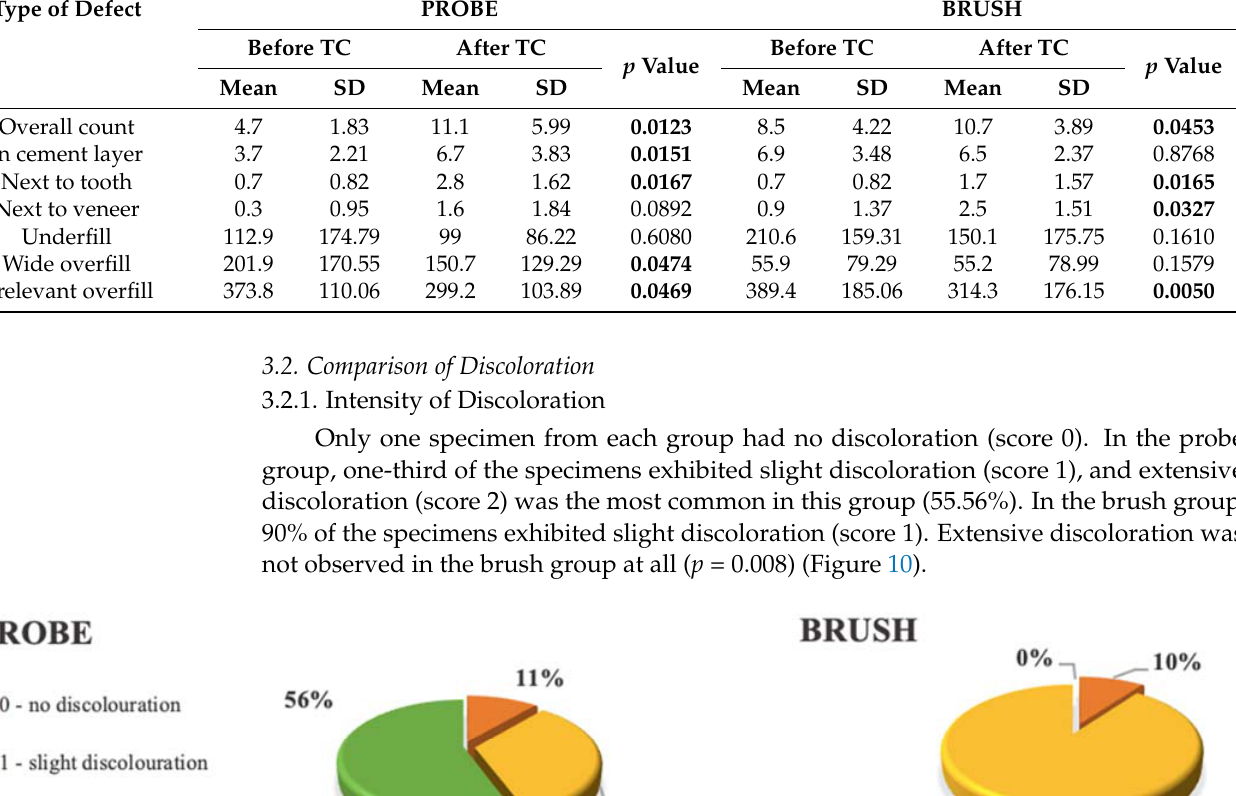
Table 2. Localization and character of defects in two groups before and after thermocycling.